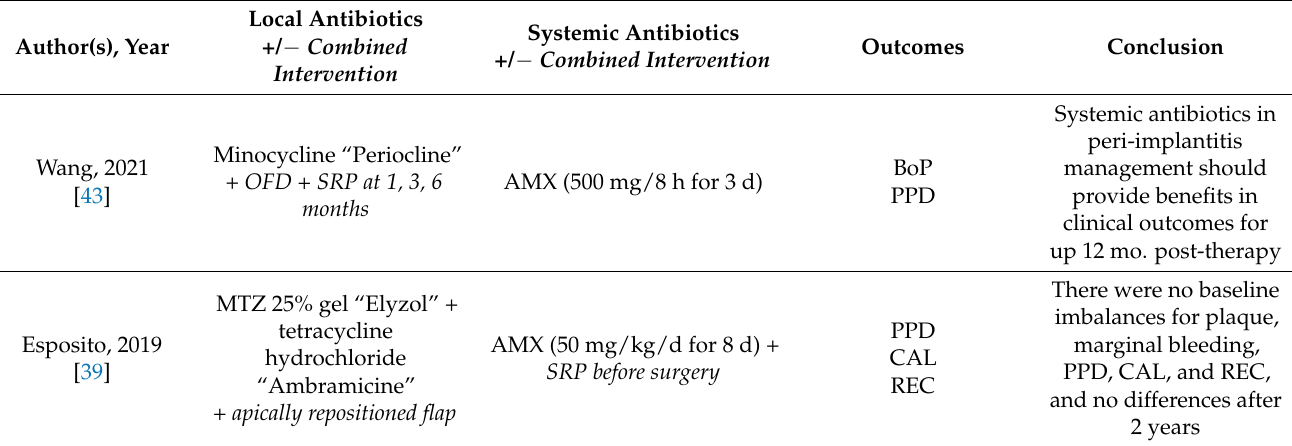
Table 7. Characteristics of local plus systemic antibiotics administration alone or combined with other interventions in treating